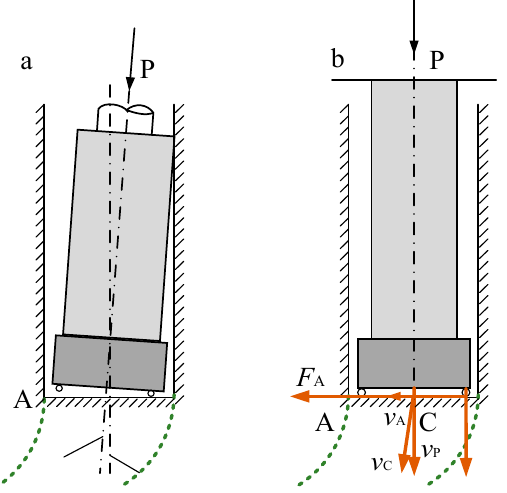
Figure 11. The hole deviation is caused by the deviation of the coarse diameter drilling tool and the asymmetry of the hole bottom breaking. ( a )—The direction of bit force deviates from the drilling axis, resulting in hole deviation. ( b )—Hole deviation caused by simultaneous axial and radial stress of drill bit. Drill axis; Original drilling